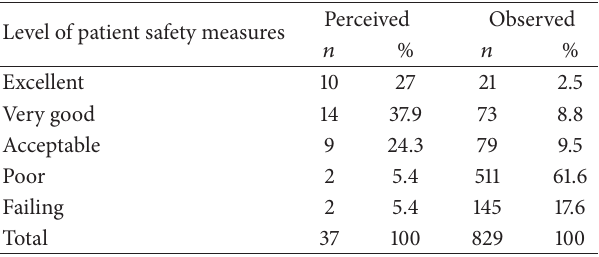
Table 1: Mean level of observed patient safety measures including the 5 different groups of procedures compared with the general perception of patient safety described in the